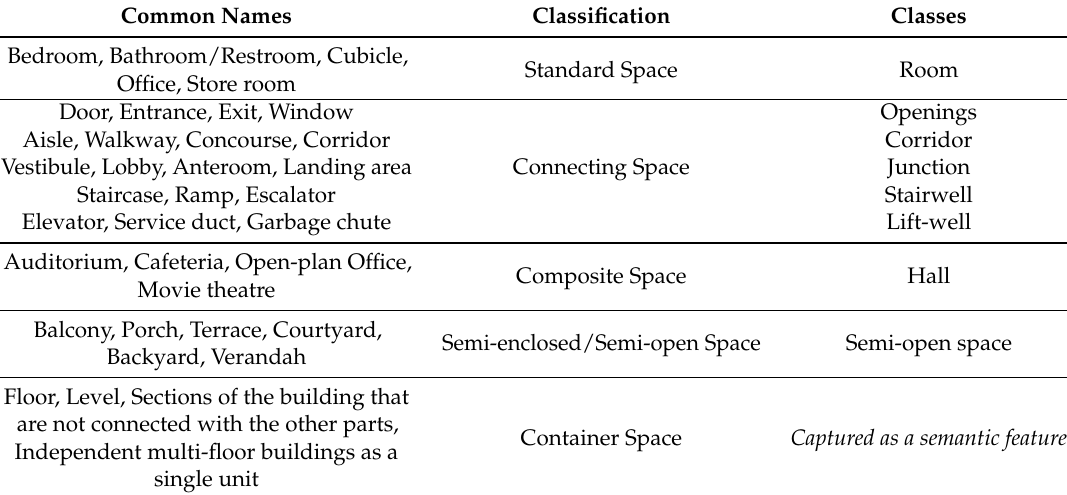
Figure 2. This figure shows the defined categories of spaces in a sample part of a building. Table 1. List of common names of spaces, their classification and mapping to the proposed